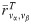
Simulated reliability and iso-reliability contour of behavioral study.For each pair of intra-subject threshold noise να and slope noise νβ, the simulated reliability averaged across Nsimulations = 1000 simulations (r¯να,νβT) is represented as a heat map. The dashed white line indicates the iso-reliability contour corresponding to the reliability obtained from the behavioral study (r = 0.212).